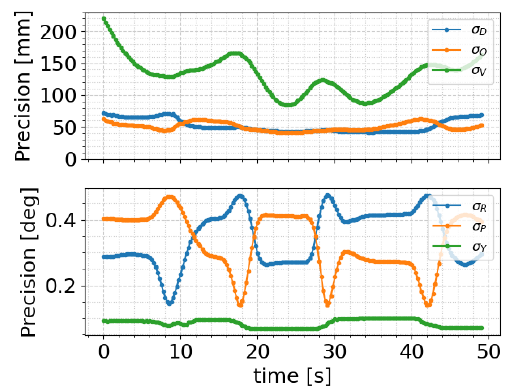
Figure 8. Exterior orientation of the vehicle and its precision as functions of